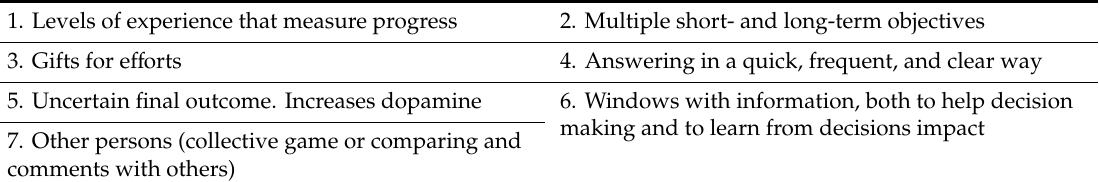
Table 1. Gamification brain reward techniques for a pleasant learning experience. Source: elaborated from Tom Chatfield